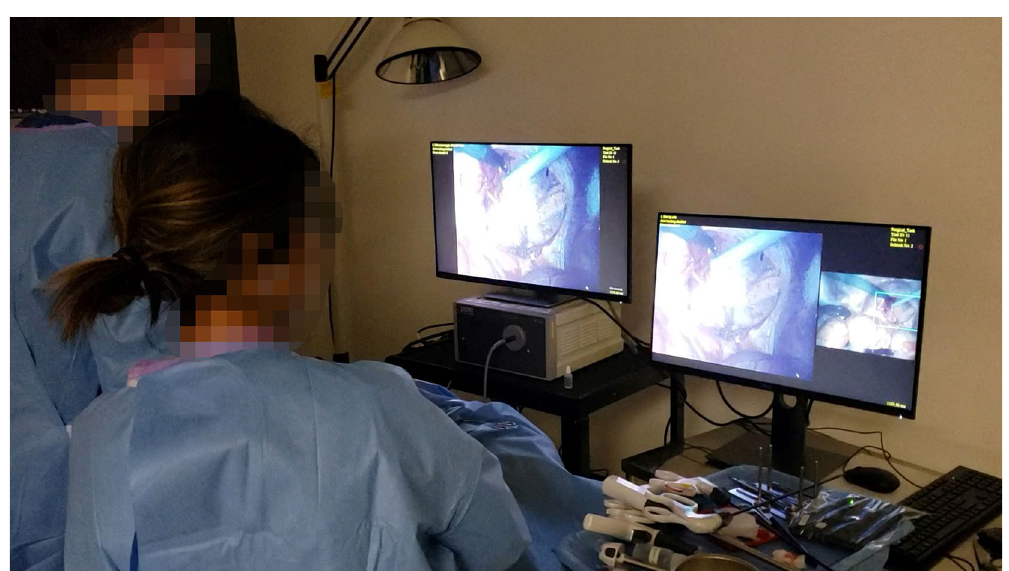
Figure 12. Photograph depicting the use of the MRFL with dual monitors during porcine surgery. The MRFL’s dual monitor feature allows a surgeon and assistant the ability to independently control the view mode displayed on their own monitor. In the instance captured above, the surgeon has opted for FST mode with the zoomed view set to full screen. The assistant, on the other hand, is using O + D mode. Either user may change their respective view mode at any time and as often as he or she sees